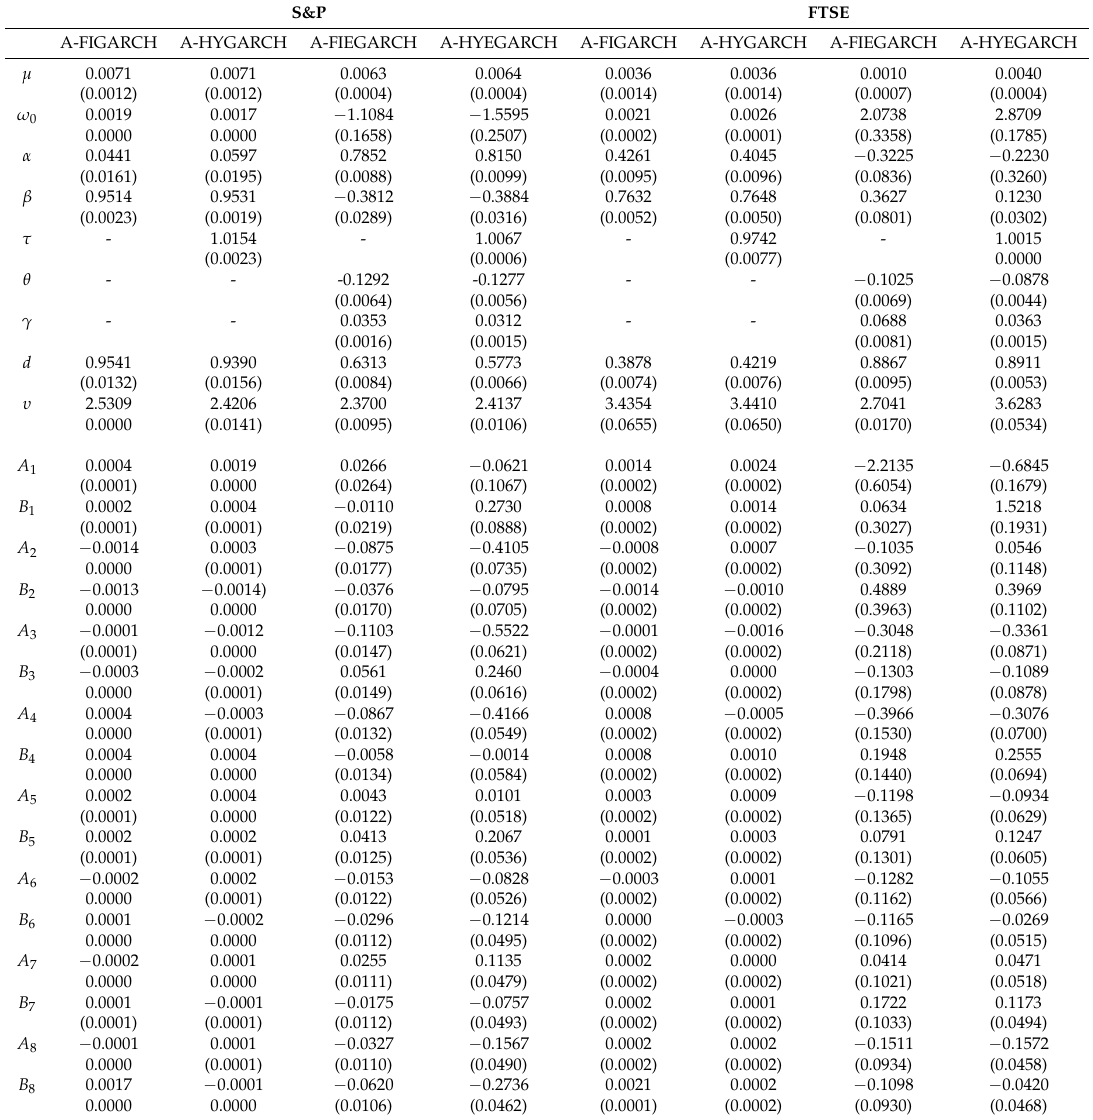
Table 8. Estimation of A-FIGARCH, A-HYGARCH, A-FIEGARCH and A-HYEGARCH models for S&P and